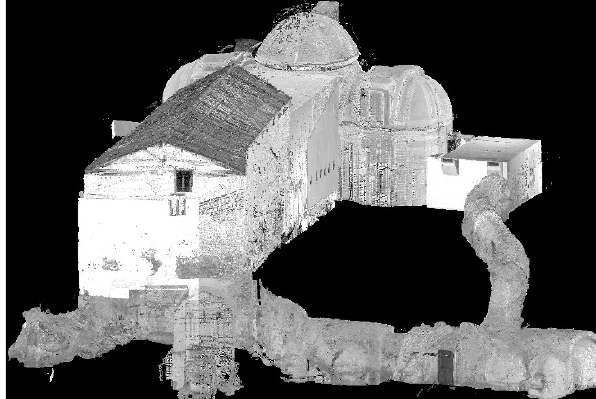
Figure 3. Laser scanner survey of the complex of the upper church and the underground connections of the